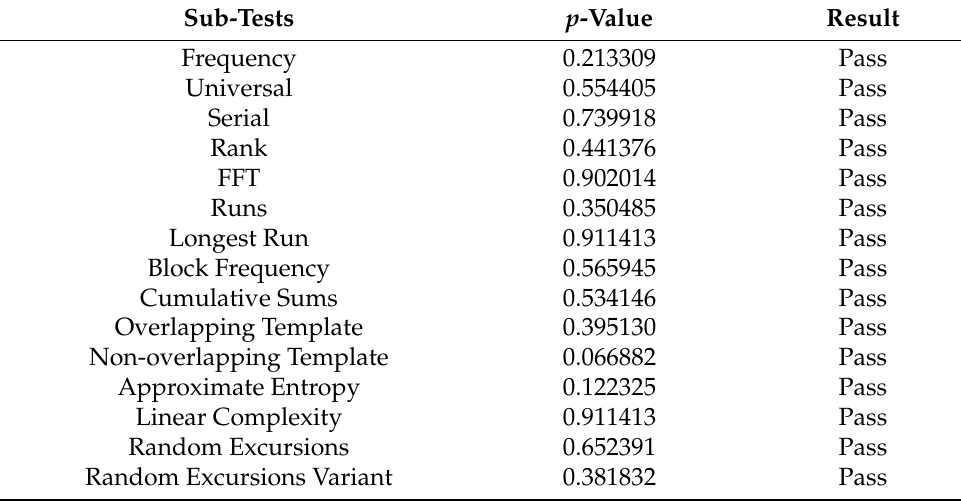
Table 2. Results of the NIST SP800-22 analyses.